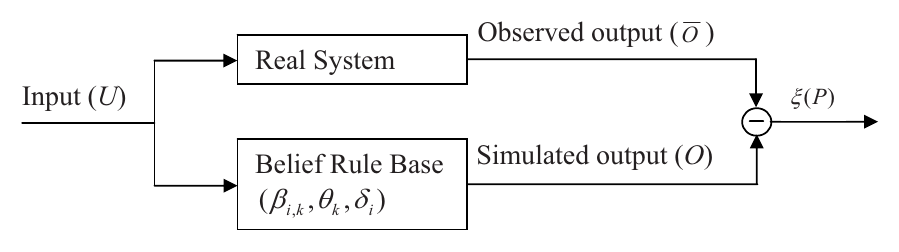
Fig. 3. Illustration of Optimal